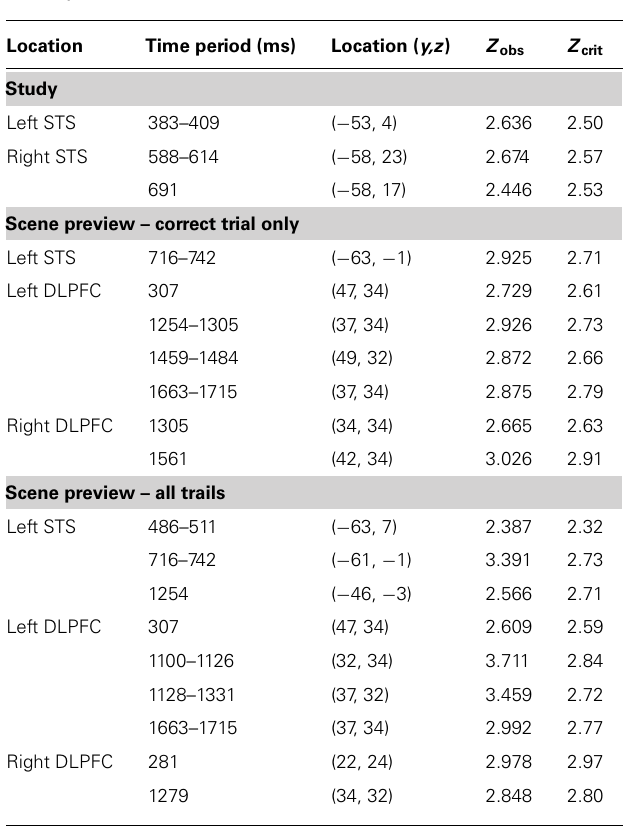
Table 2 | Locations and statistical analyses for areas found to be active during study (faces > scenes) and scene preview (old scenes >